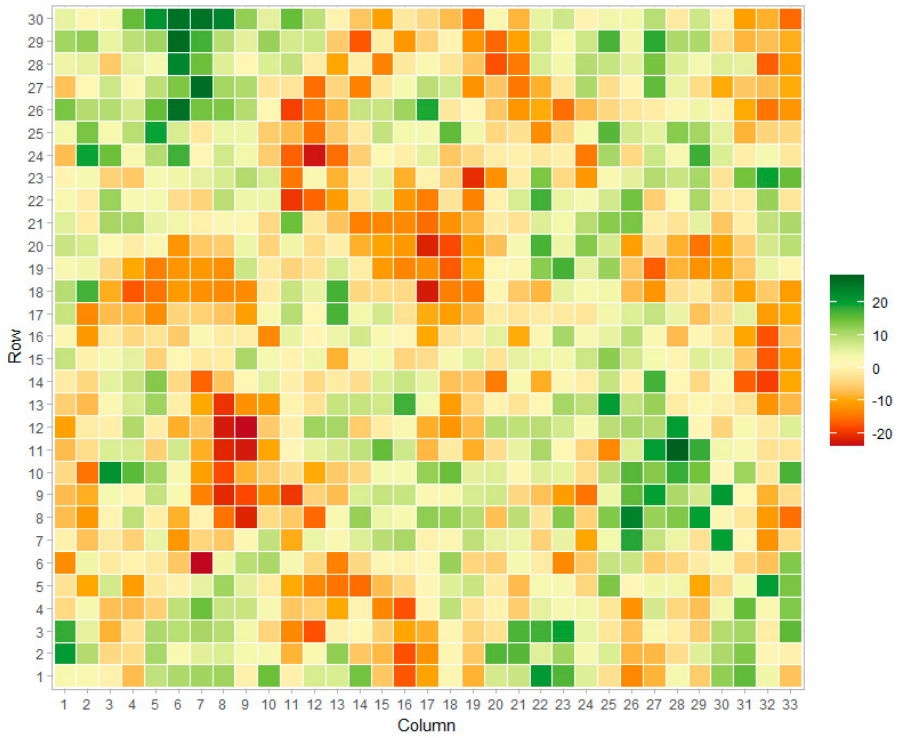
Figure 2. Example of simulated field signal using the Matérn function.